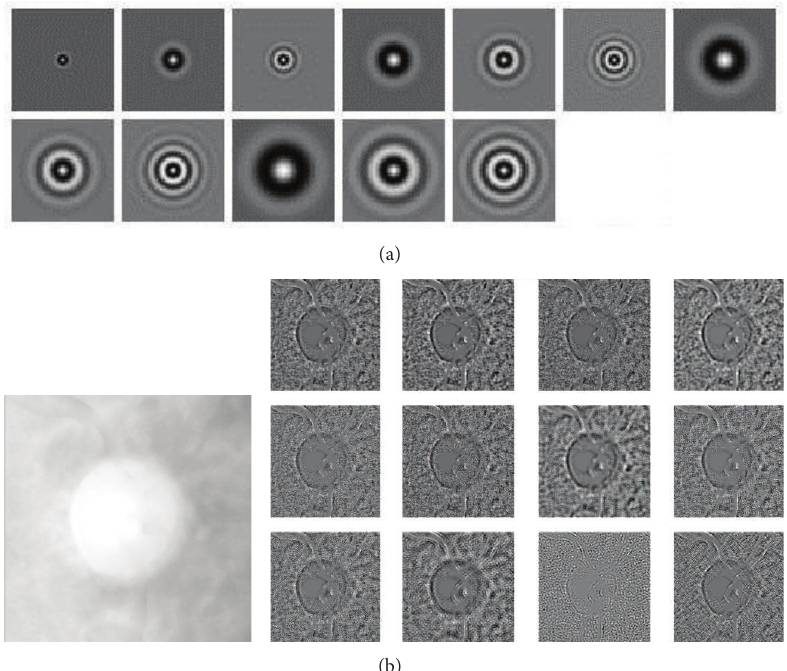
Figure 5: Schmid filter banks and results. (a) The Schmid filter bank. (b) The left one is the raw image. The right is the first twelve responses from